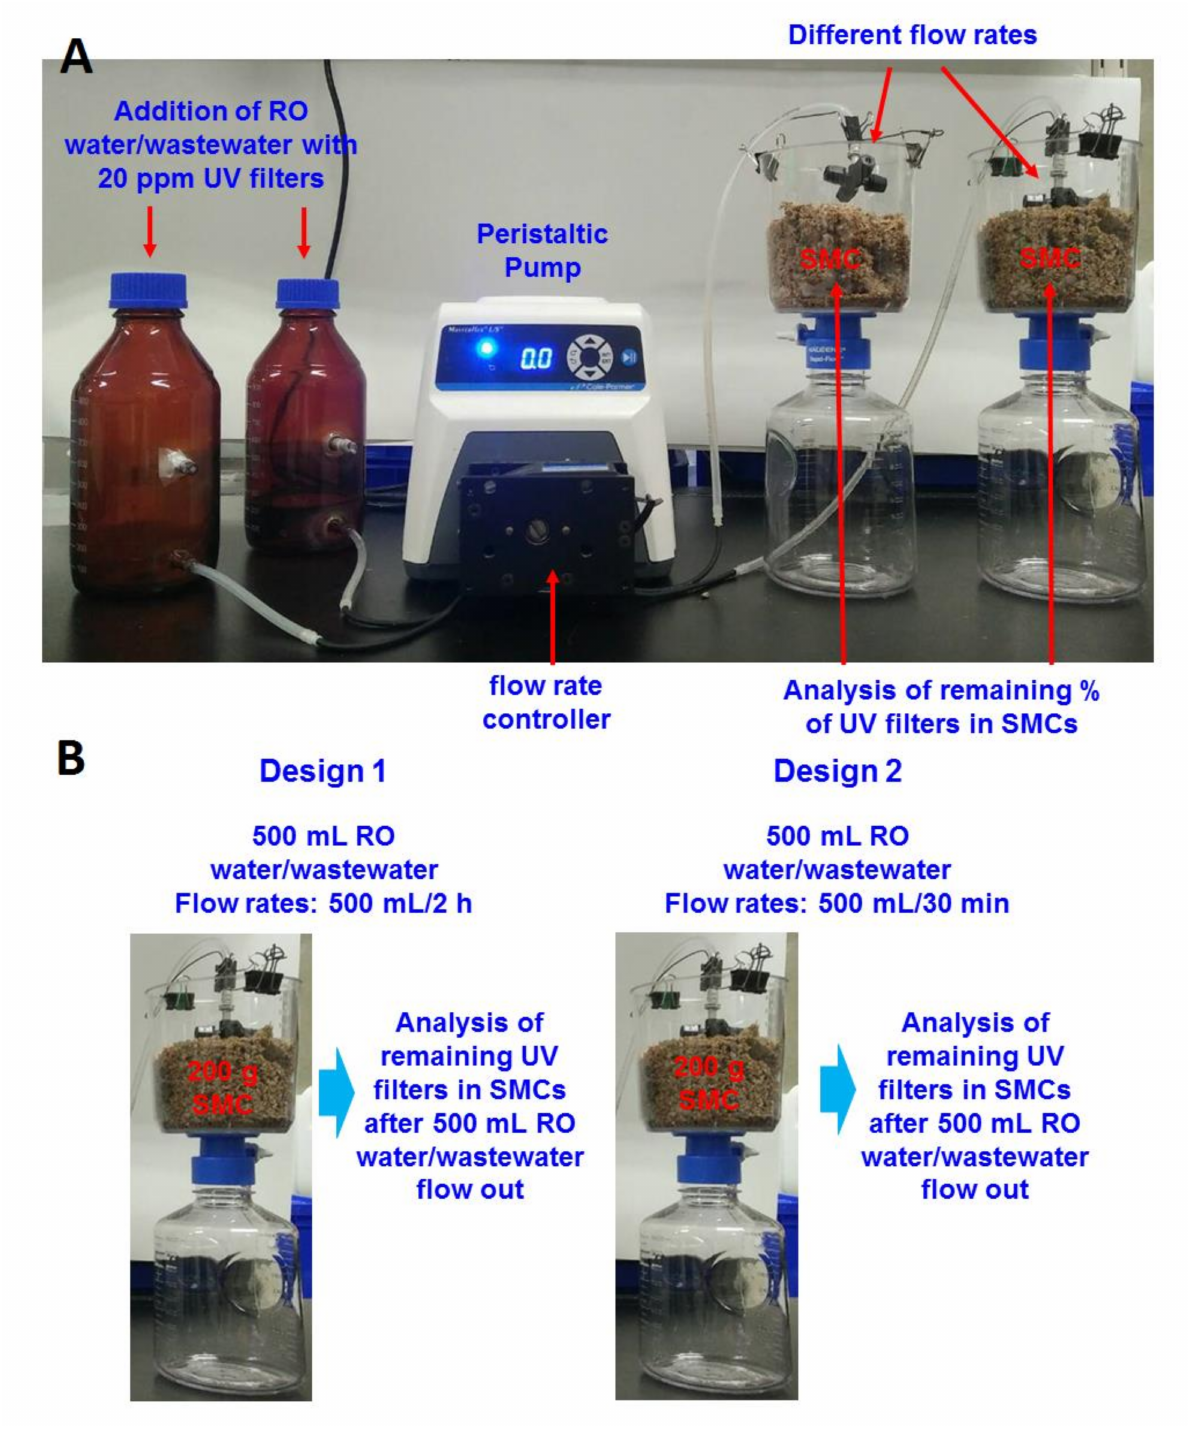
Figure 2. Experimental settings of bioreactor experiments. ( A ) A 500 mL volume of RO water/wastewater with a 20 ppm UV filter was fed to the bioreactors using a peristaltic pump as a flow rate controller. ( B ) Two flow rates: 500 mL/2 h and 500 mL/30 min were used in this study. The remaining (%) of each UV filter in SMCs was determined after 500 mL of RO water/wastewater flow through SMCs. SMC: spent mushroom